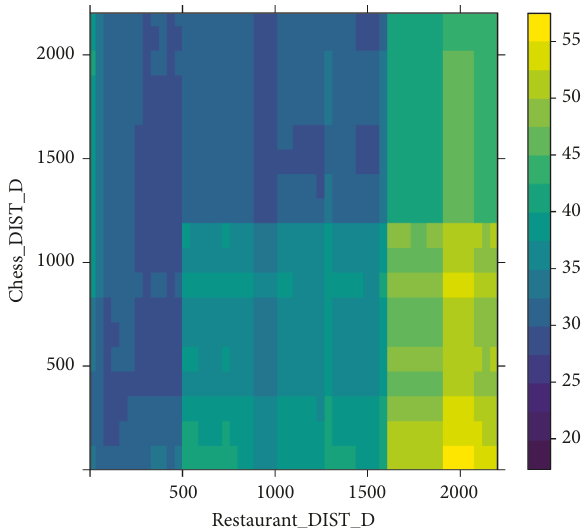
Figure 8: Interactive effects on trip time between distances to the nearest restaurant and chess/card room on the alighting side (H-statistic � 41.6%, the color bar stands for trip